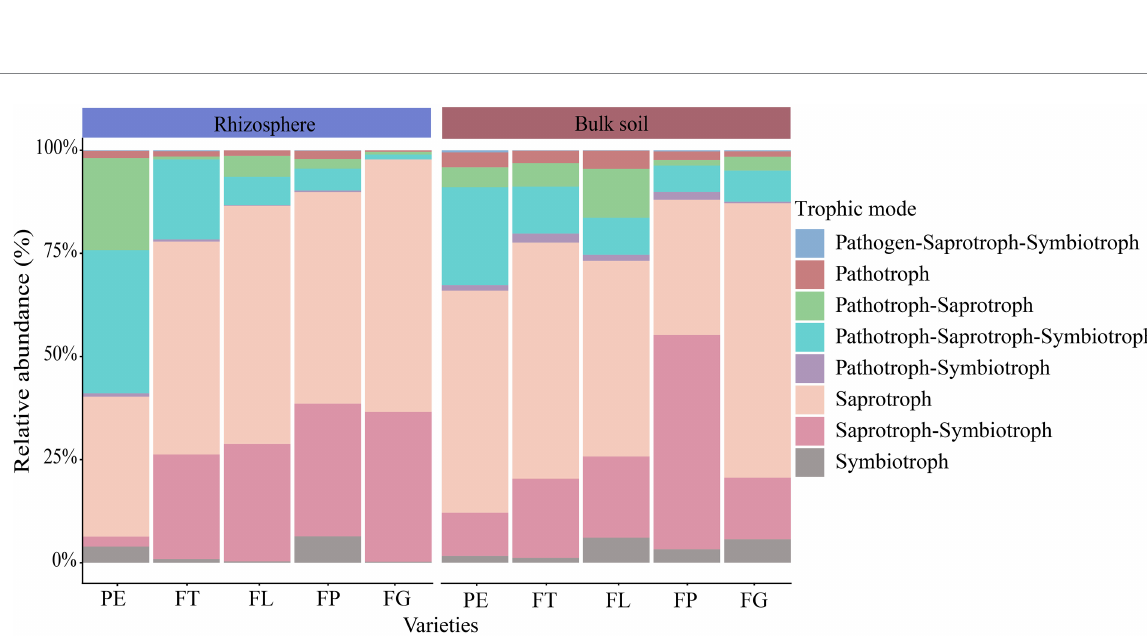
FIGURE 5 Relative abundance of fungal trophic modes in different soil compartments and bamboo varieties. PE, Phyllostachys edulis ; FT, P. edulis f. tao kiang ; FL, P. edulis f. luteosulcata ; FP, P. edulis f. pachyloen; FG, P. edulis f. gracilis